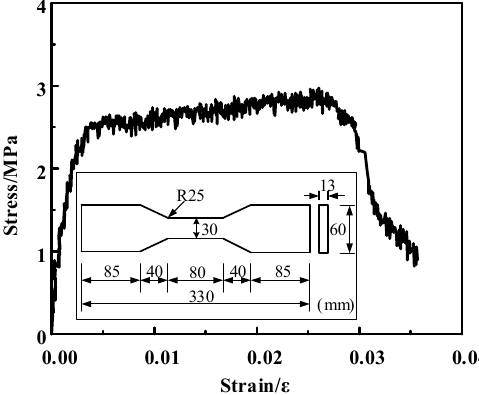
Figure 5. Stress-strain curve of ECC under tension. Table 2. ECC mix ratio in mass.